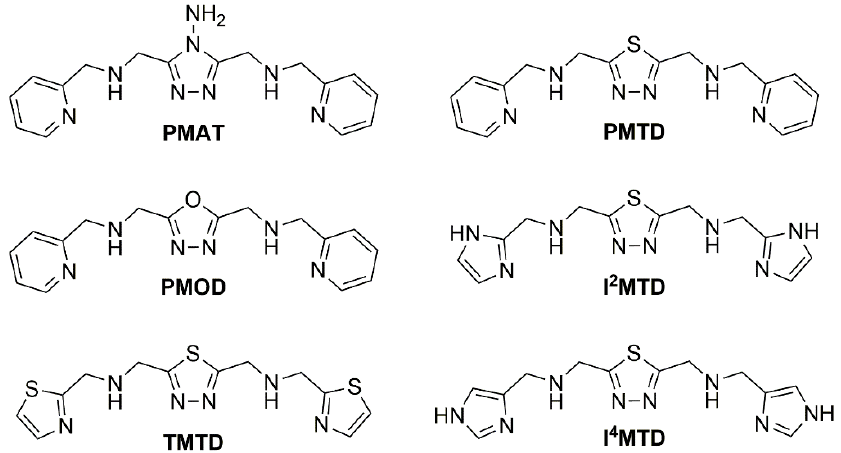
Figure 1. Summary of the ligand systems mentioned in the introduction.